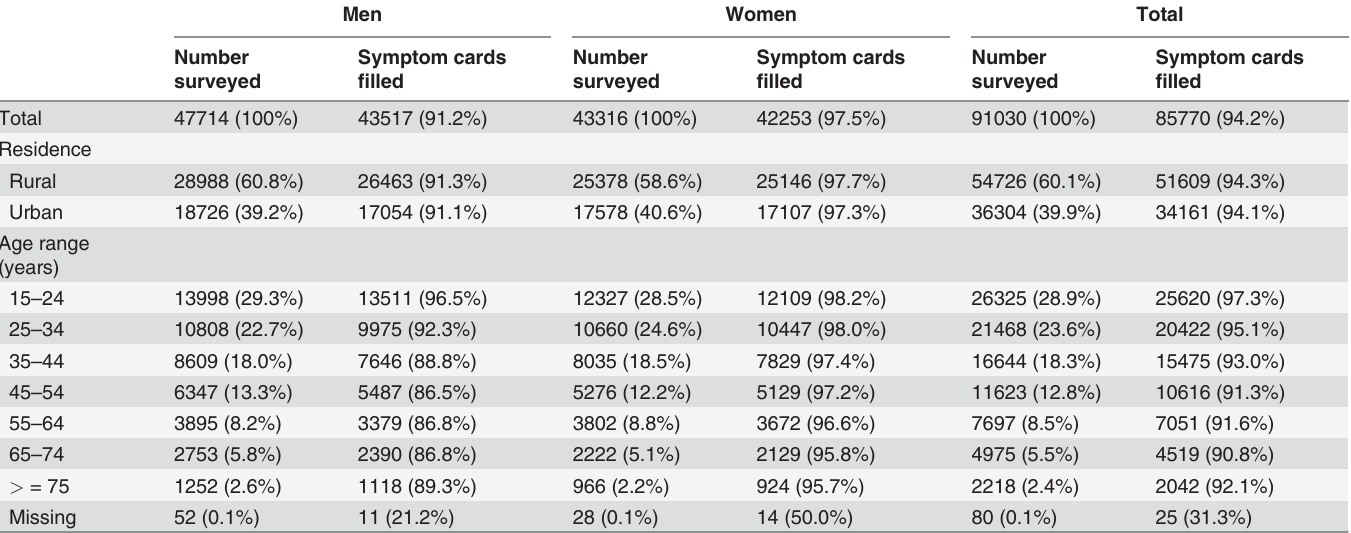
Table 1. Age and gender distribution of study